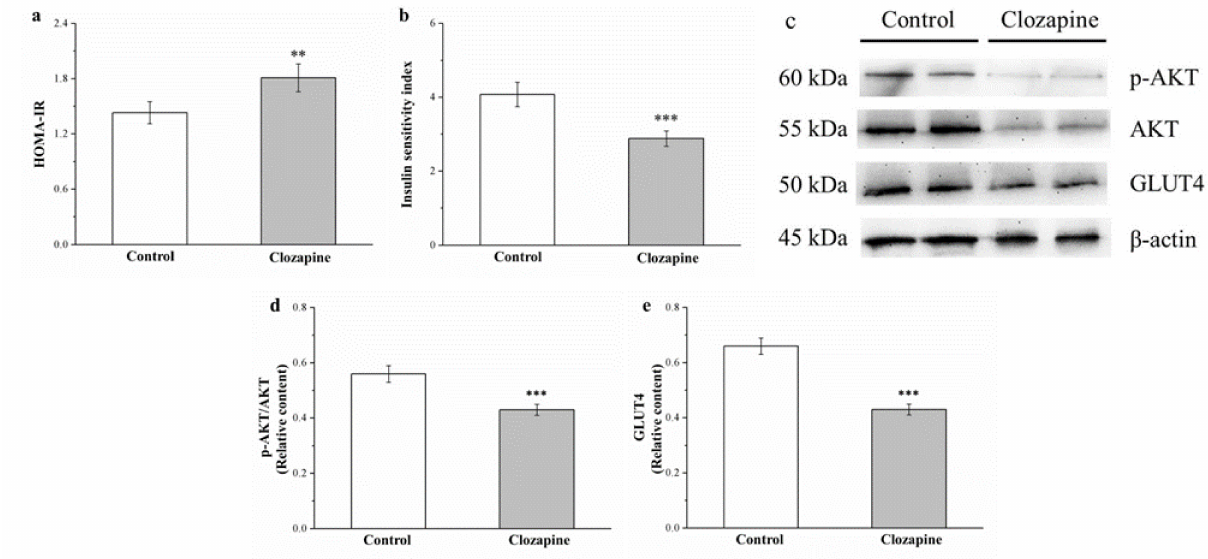
Figure 7. ( a ) Homeostatic model assessment for insulin resistance (HOMA-IR) and ( b ) insulin sensitivity indices; ( c ) representative blot of muscle extracts; and ( d ) Akt phosphorylation and ( e ) GLUT4 expression in gastrocnemius muscle in clozapine (receiving 2 mg/kg/day) and control groups for 8-week experimental period. Data are mean ± standard deviation ( n = 10). ** p < 0.05, *** p <